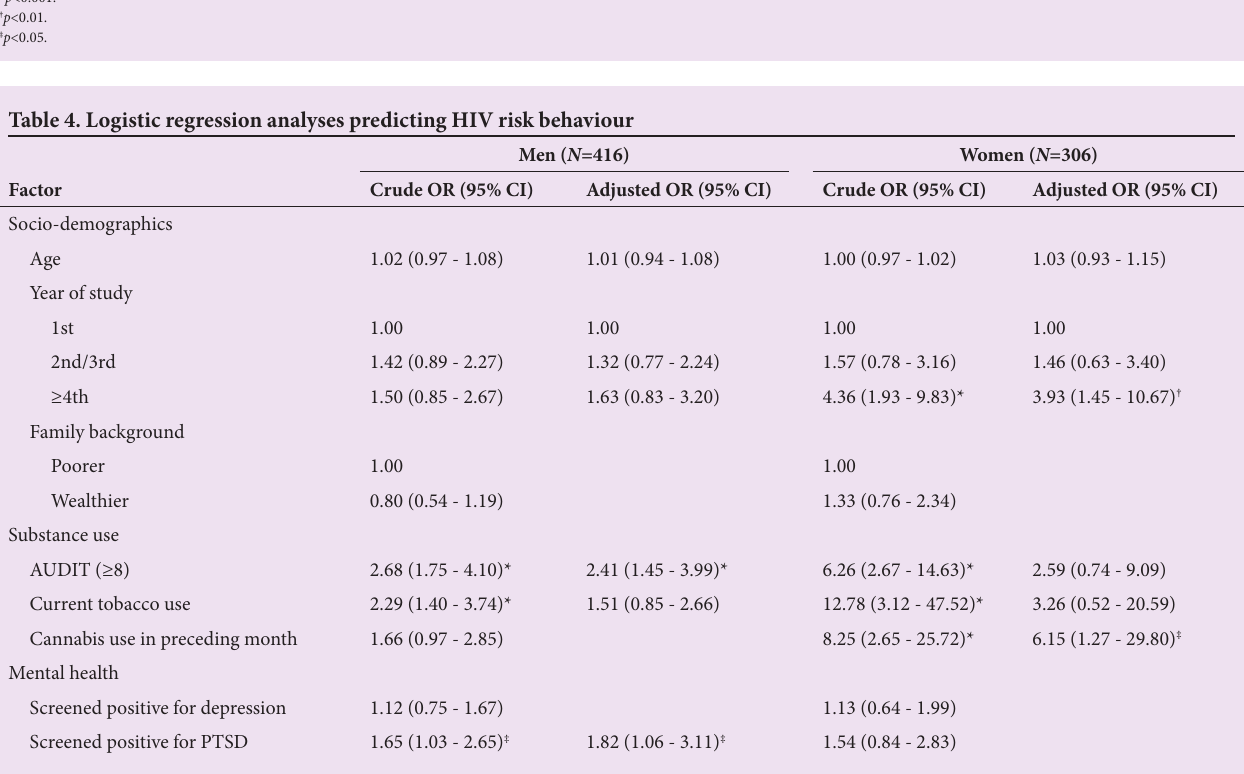
Mental health Screened positive for depression 1.12 (0.75 - 1.67) Screened positive for